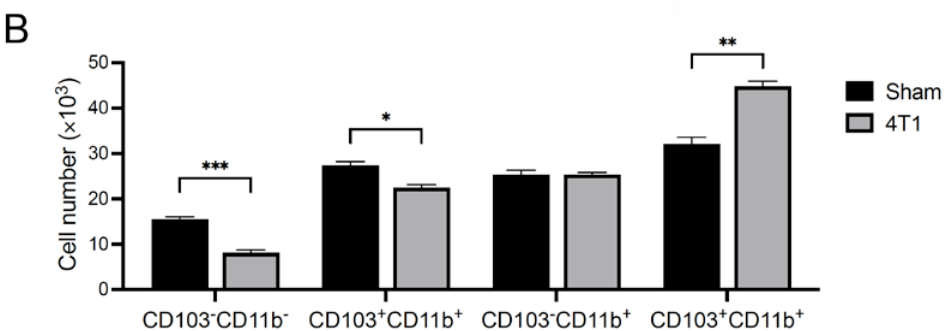
Figure 5. MLN CD103 + CD11b + DCs were increased in 4T1 tumor mice. At day 21 of transplantation into the right flank transplantation, mLNs from control (Sham) or tumor (4T1)-bearing mice were isolated. ( A ) Representative flow cytometry plots and ( B ) the total number of CD103 + CD11b − , CD103 + CD11b + , CD103 − CD11b − , and CD103 − CD11b + in CD11c + MHCII high migratory DC subsets. Numbers in plots indicate the percentage. Data are shown from a representative experiment from four independent experiments. The mean ± SEM and assessed with a Mann–Whitney U test. * p < 0.05; ** p < 0.01; *** p < 0.005.